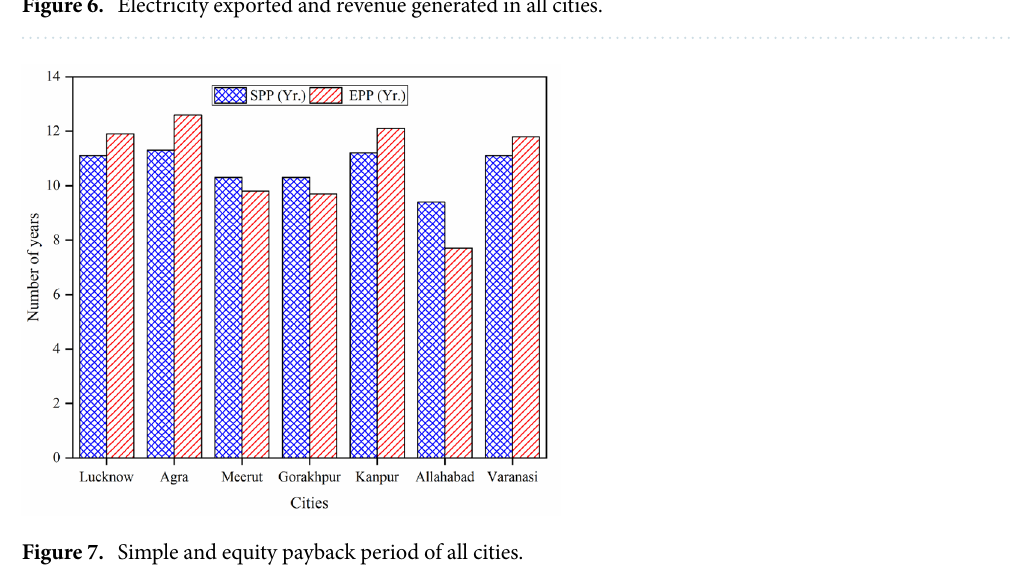
Figure 6. Electricity exported and revenue generated in all cities.